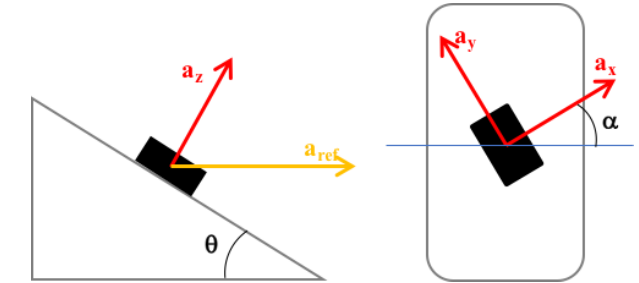
Figure 1. Geometrical representation of angles, with respect to the reference acceleration ( a ref